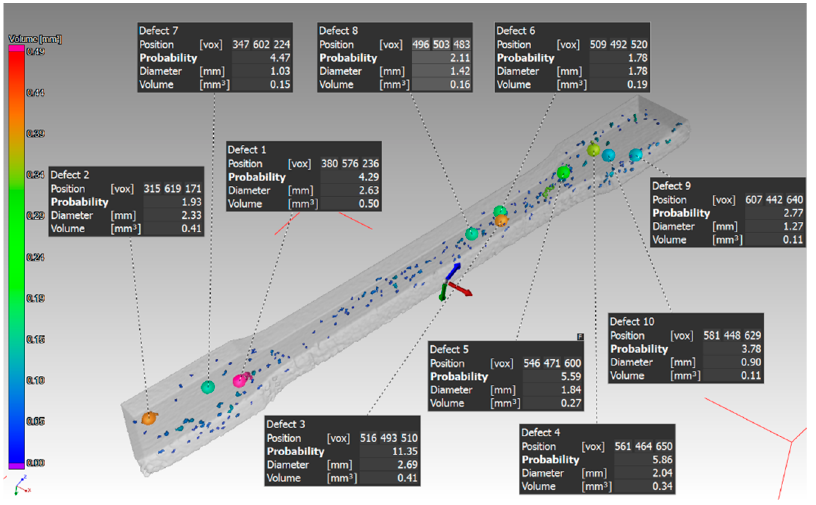
Figure 16. Specific defects in the sample with thickness of 3 mm, which was oriented in XZ.